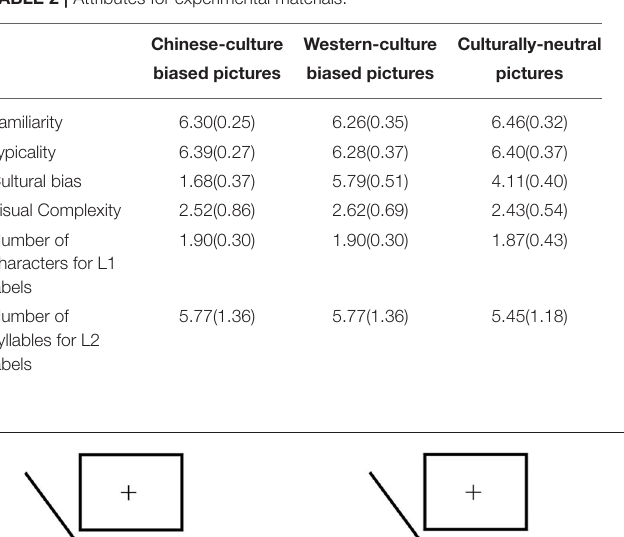
TABLE 2 | Attributes for experimental materials.